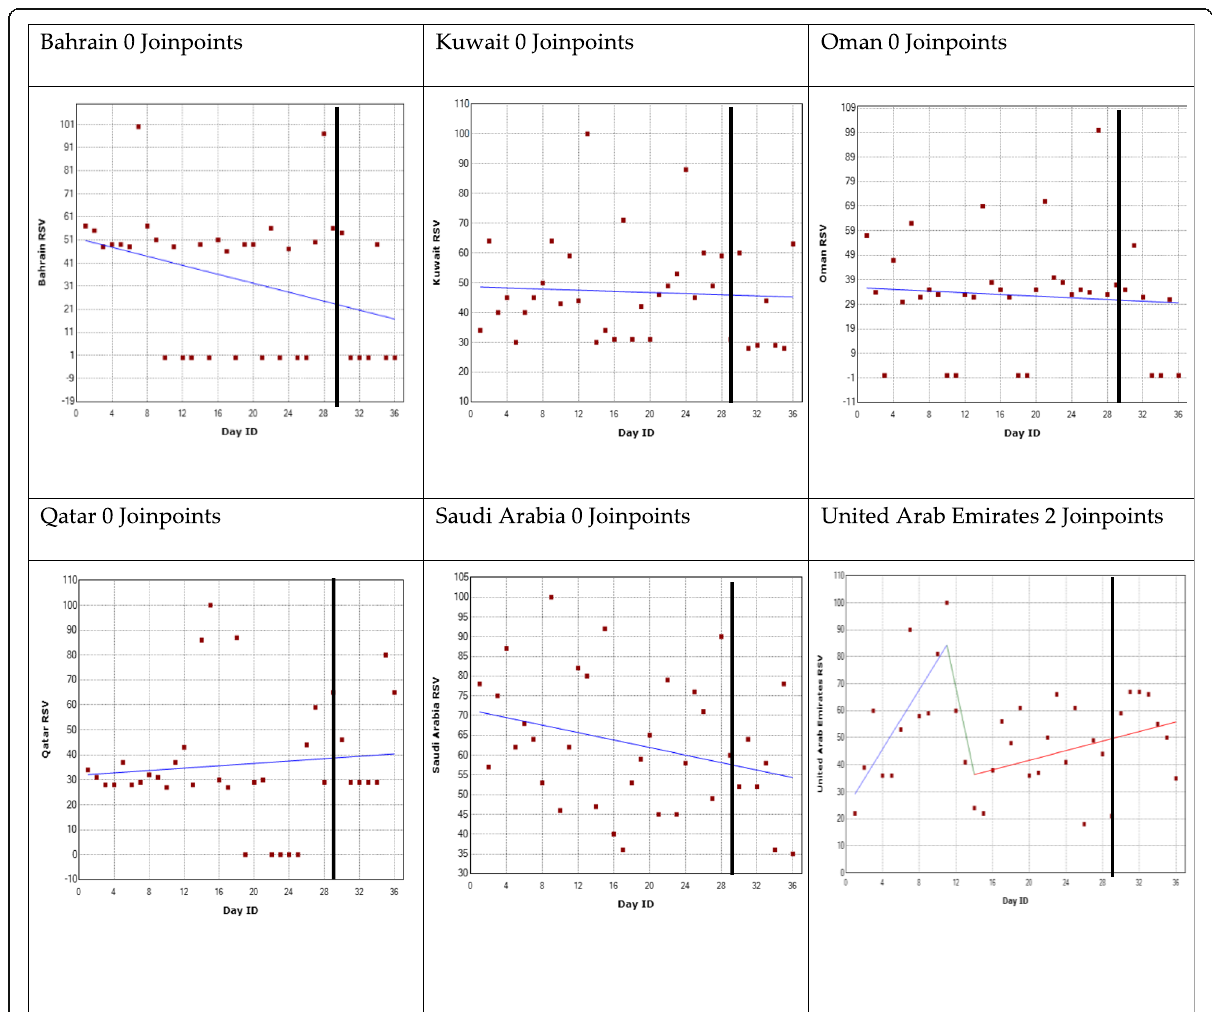
Fig. 5 World Hypertension Day joinpoint regression analysis. *The black vertical line represents the global public health day